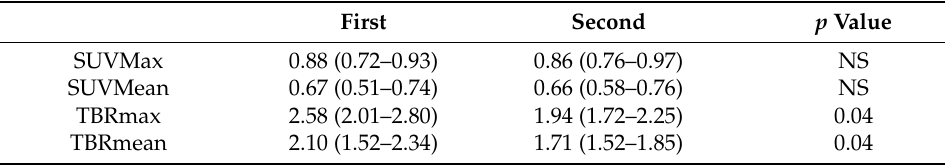
Table 2. TBR max and TBR mean in vascular territories .